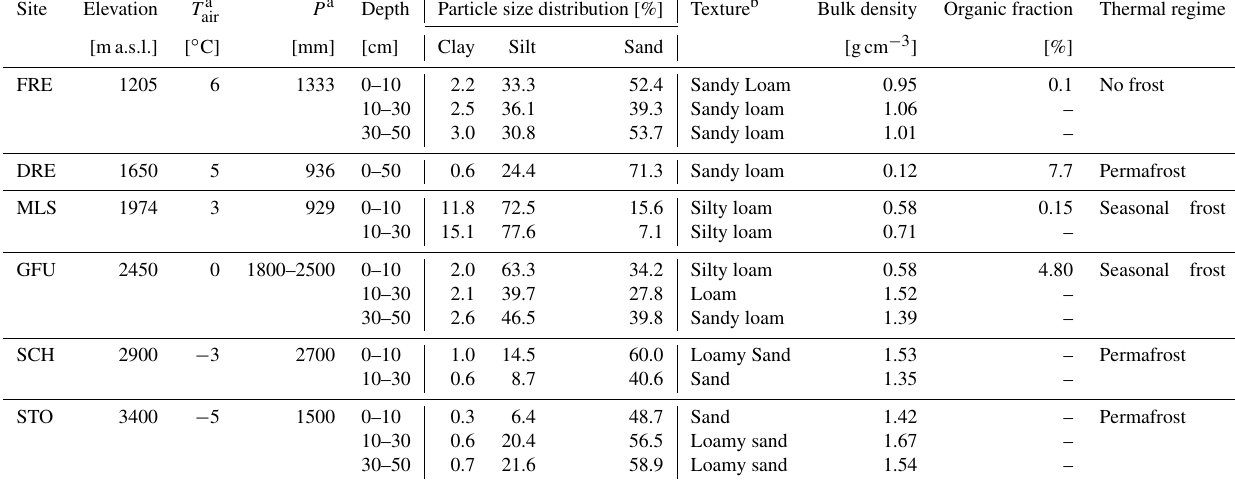
Table 3. Summary of the climatic conditions and soil properties at each SOMOMOUNT